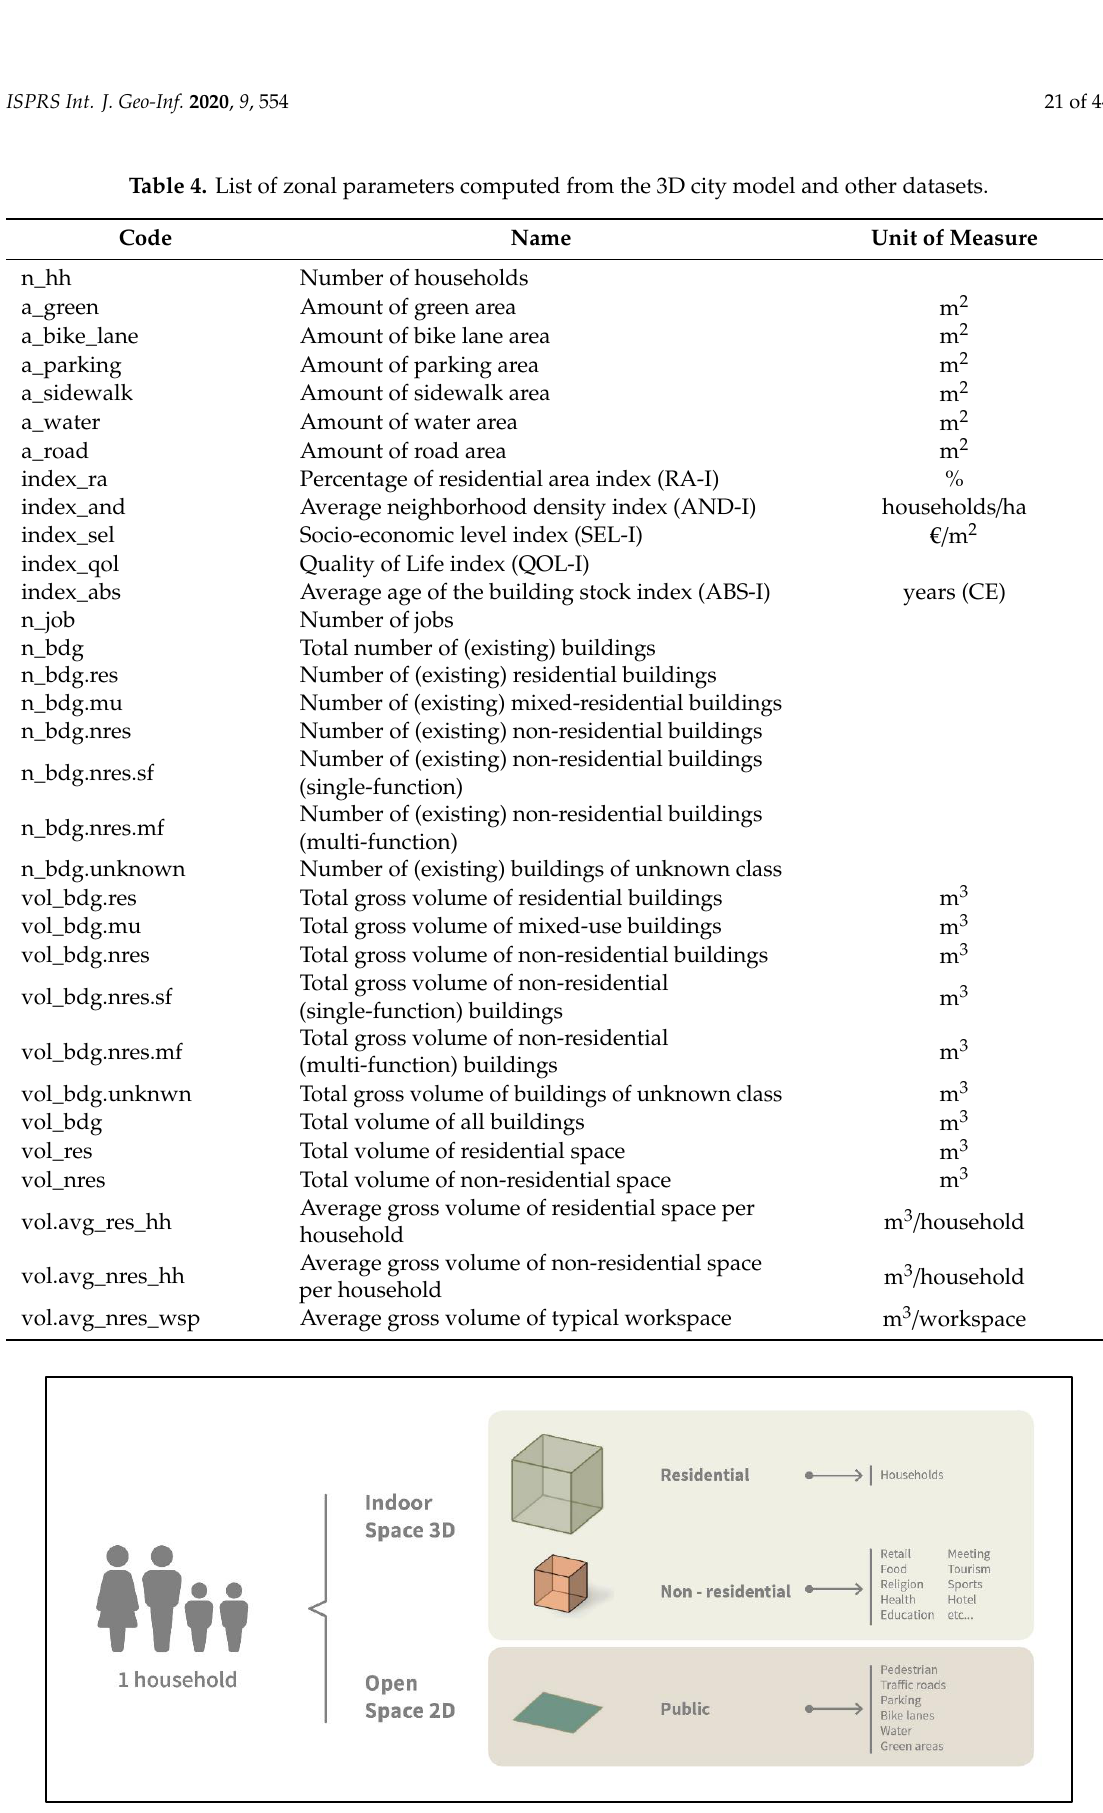
Figure 16. Example of two prototypic buildings used for comparison. Each building represents the living-space values of the corresponding neighborhood (e.g., Bellamybuurt Noord and Passeerdersgrachtbuurt). 3.3. Parametric Urban Design (Step 3) The third step of the methodology is where the “city of tomorrow” starts being shaped by urban planners combining professional knowledge, experience, and data from the “city of today”. In this work, the chosen environment to design the new development area (via multiple scenarios) is Rhinoceros, as 3D modelling software, and Grasshopper, as its embedded graphical algorithm editor. The reason is that these are two very well-known and commonly used software packages in the field of urban and architectural parametric design. 3.3.1. Internal and External Design Parameters Two different sets of design parameters and objects were first defined and integrated into a newly-developed prototypic workbench based on Rhinoceros/Grasshopper. The first one, defined as a set of “external parameters and constraints”, is meant to implement guidelines established by a municipality or another policy-making institutional body. In the case of the Municipality of Amsterdam, for example, these guidelines are conceived to allow for a seamless transition between the new development area and its surroundings. They prescribe the maximum height of different types of buildings, as well as the overall development targets to be achieved in the new development